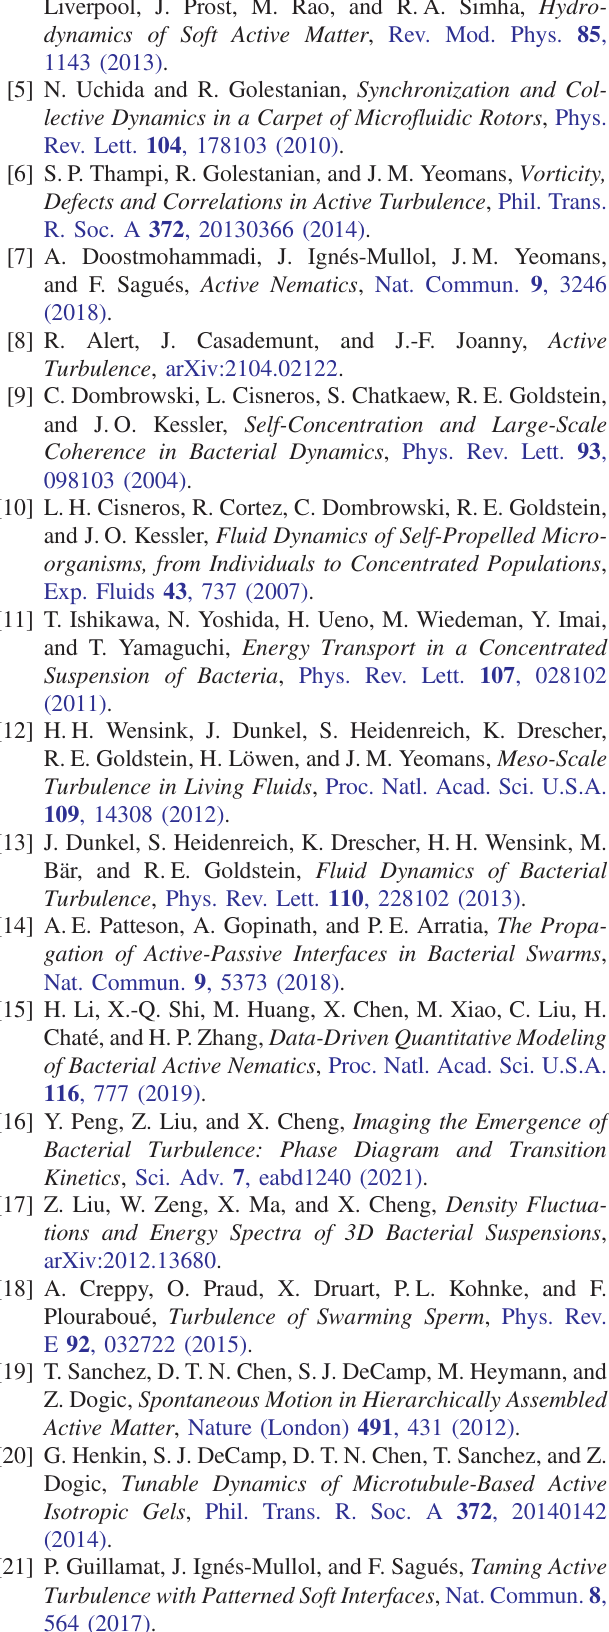
ffiffiffiffiffiffiffiffiffiffiffiffiffiffiffiffi p 2 þ r= 2